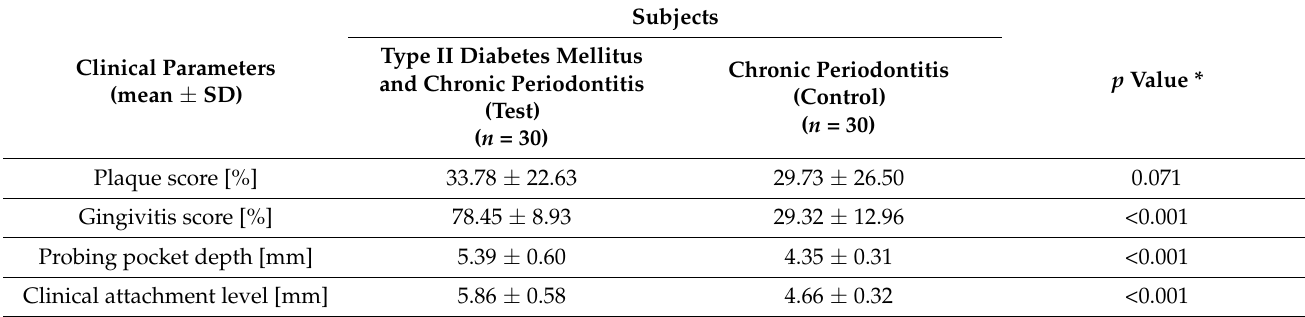
Table 2. Periodontal parameters of subjects.